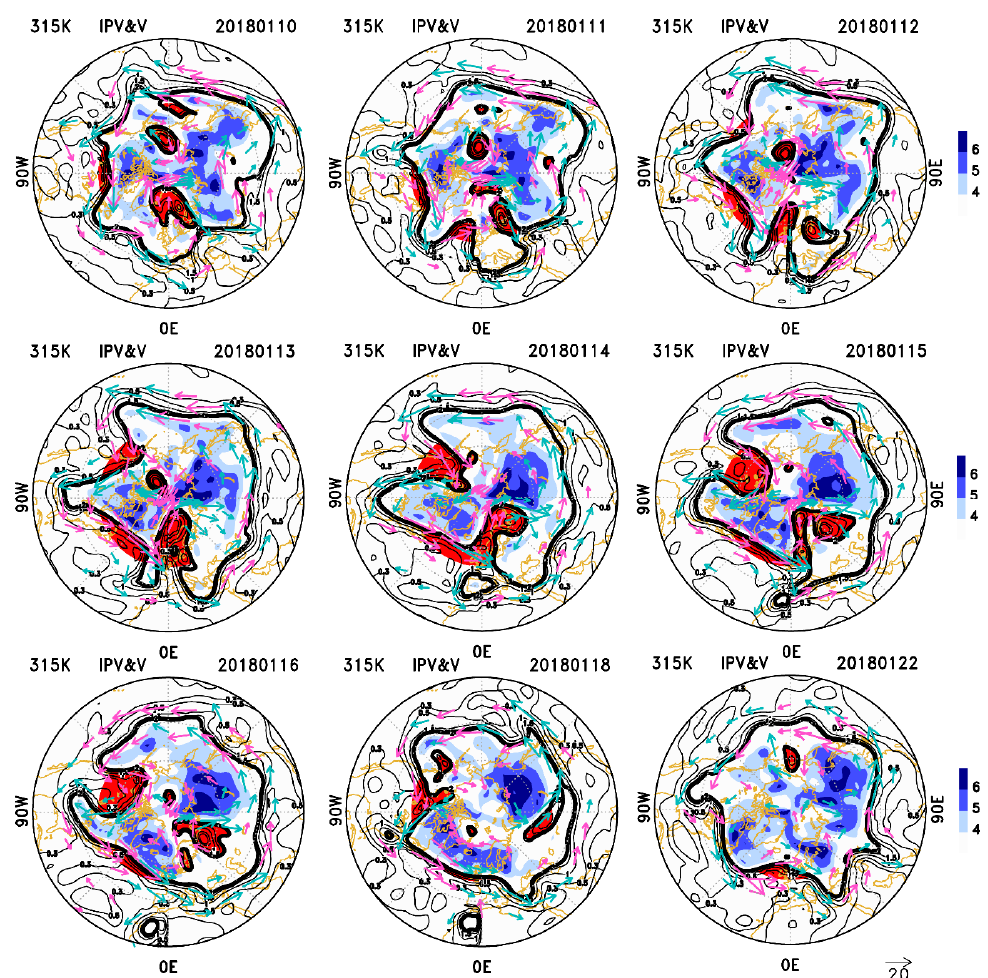
Figure 5. 315 K isentropic PV (contour, units: PVU) and wind (arrow, units: m s − 1 ) fields on some given dates in January 2018. The purple and blue arrows represent southerly and northerly, respectively, and wind speed larger than 15 m s − 1 . PV in the blue shade is greater than 4 PVU; PV less than 2 PVU in the north of 50° N is marked in red. The thick solid contours are 2 PVU.